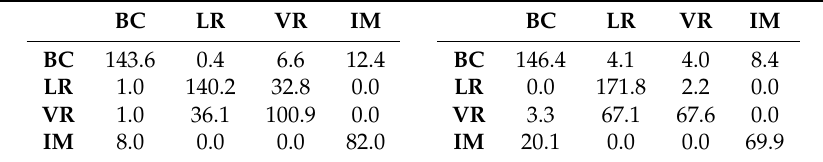
Table 4. Average confusion matrix resulting from the SVMl/LDA classifier combo, which achieved the best overall accuracy of 82.6% (left), and from the KNN/SVMp classifier combo, which achieved the most consistent accuracy ranging from 63.2% to 97.5%, with an average of 80.6%